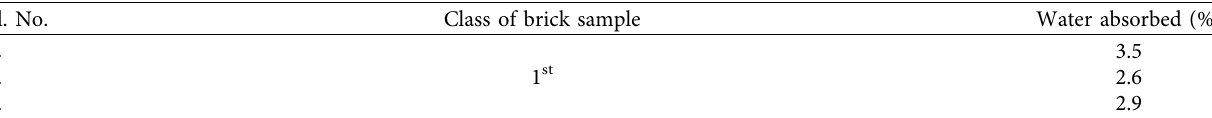
Table 6: Water absorption test result on locally available conventional brick bought from a local market. Sl. No.